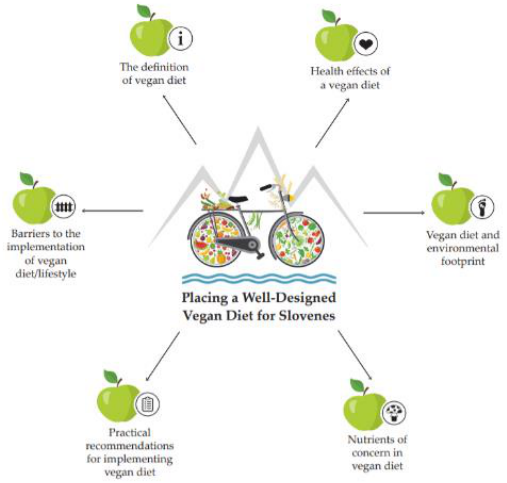
Figure 1. Placing a Well-Designed Vegan Diet for Slovenes.